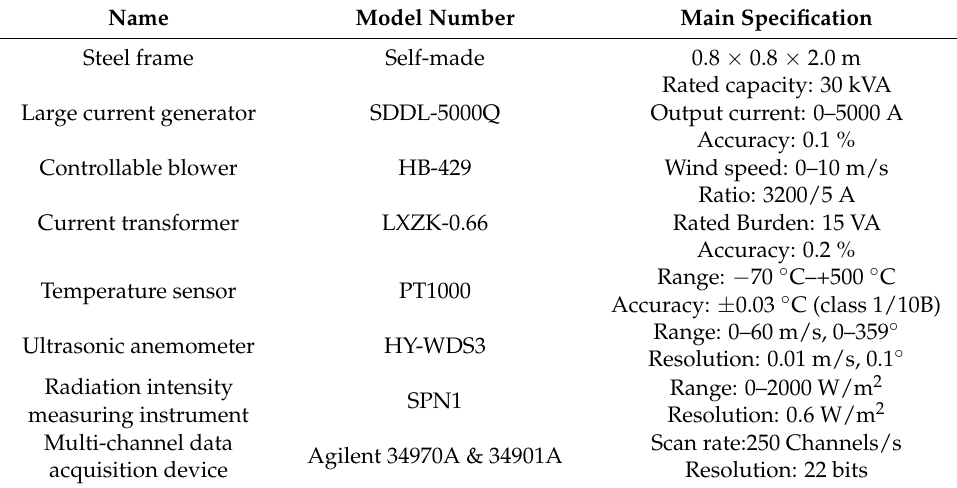
Table A1. Main parameters of experimental equipment in temperature rise test platform.